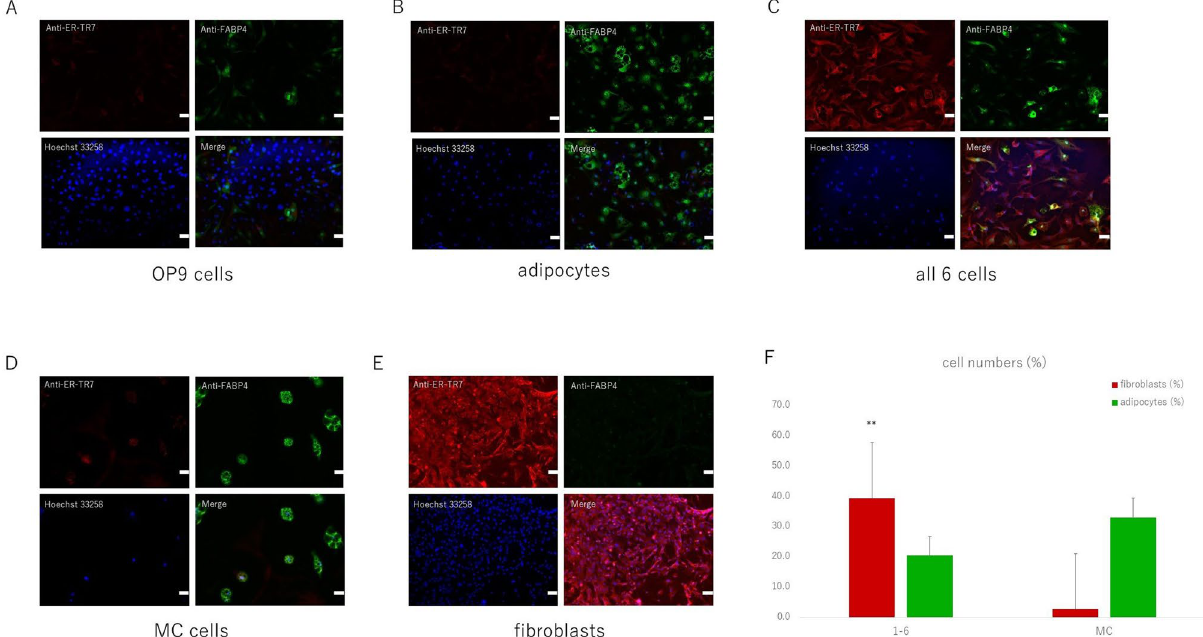
Figure 4. Immunofluorescence staining for anti-ER-TR7 (red) and anti-FABP4 (green). Hoechst 33258 (blue) was used for visualizing nuclei. ( A – E ) Combination of anti-ER-TR7 and anti-FABP4 expression in OP9 cells ( A ) and in adipocytes ( B ). Anti-ER-TR7 and anti-FABP expression was less in OP9 cells, whereas anti-FABP expression was appreciable in adipocytes. Expression of anti-ER-TR7 and anti-FABP4 in all 6 cells ( C ), MC cells ( D ), and fibroblasts ( E ). Anti- ER-TR7 expression was higher in all 6 cells and fibroblasts than in MC cells, whereas anti-FABP4 expression showed reverse results. Scale bars, 50 µm. The number of fibroblasts, stained by anti-ER-TR7, and number of adipocytes, stained by anti-FABP4, in all 6 cells and MC cells are showed as a percentage. The percentage of fibroblasts in all 6 cells was much more than that in MC cells ( F ). (n = 10) Values shown are the means + SEM. P-values were determined by a Student’s t-test. **P <